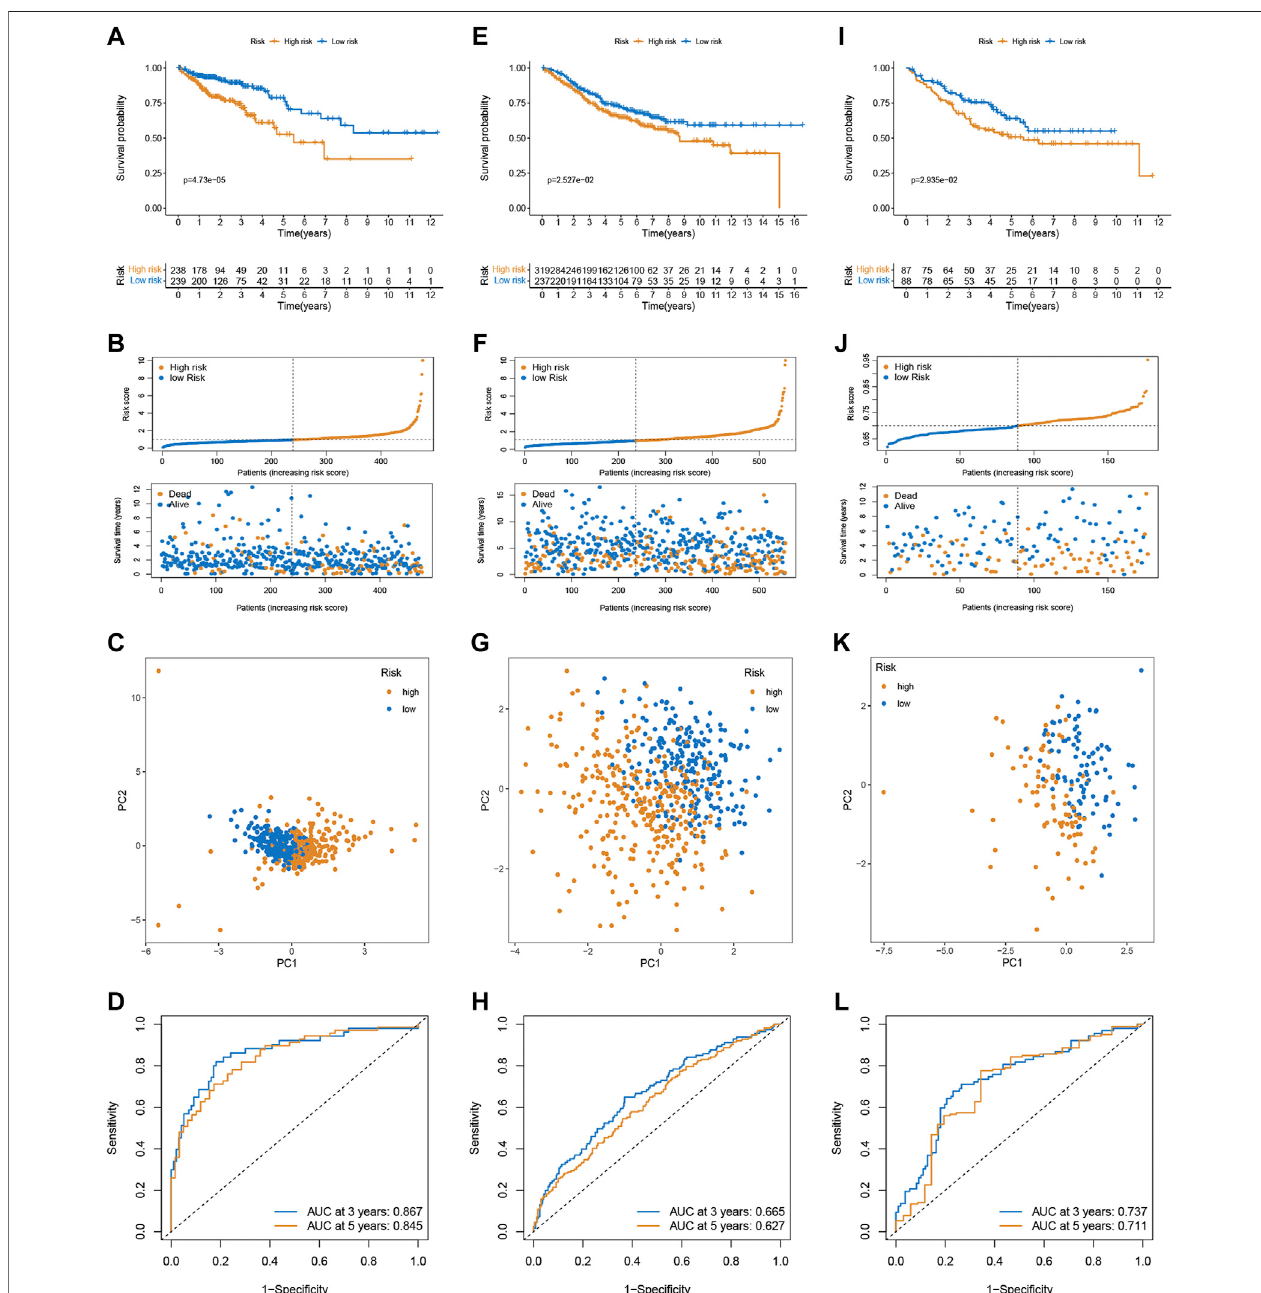
FIGURE 2 | Validation of the prognostic prediction performance of the signature. Kaplan-Meier survival analysis in the training (A) , GSE39582 (E) , and GSE17536 cohort (I) . Distribution of riskscore and survival status in the training (B) , GSE39582 (F) , and GSE17536 cohort (J) . PCA analysis in the training (C) , GSE39582 (G) , and GSE17536 cohort (K) . Time-dependent ROC curves of risk scores in the training (D) , GSE39582 (H) , and GSE17536 cohort (L) .